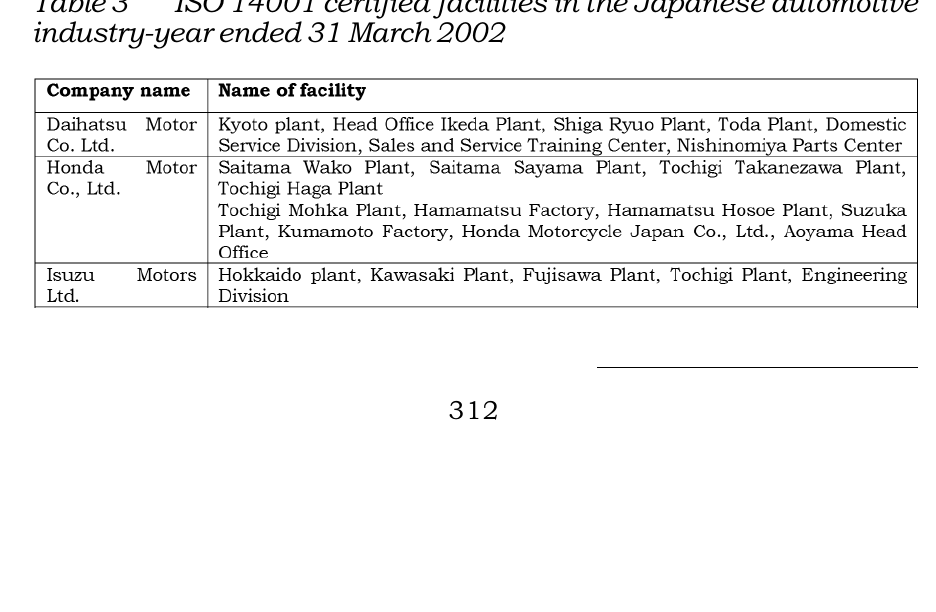
ISO 14001 certified facilities in the Japanese